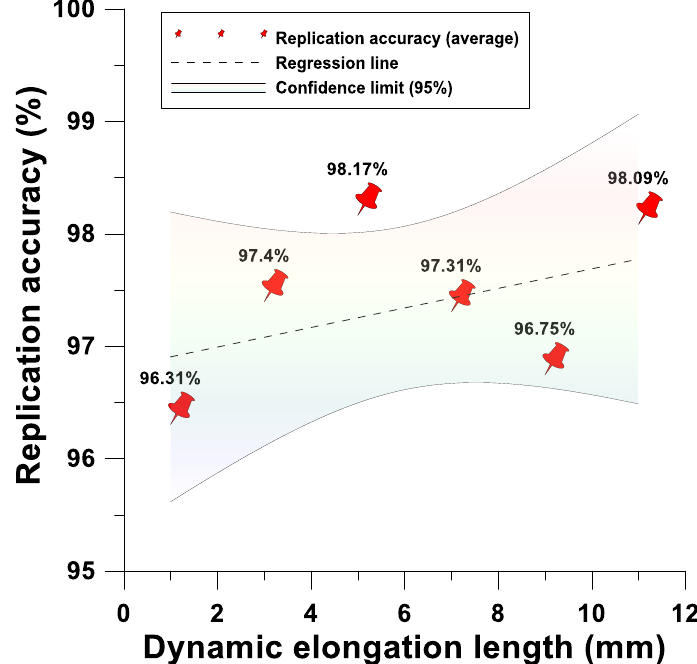
Figure 22. Dynamic tensile and gasbag-assisted imprinting process microstructure diameter imprint transcription rate.